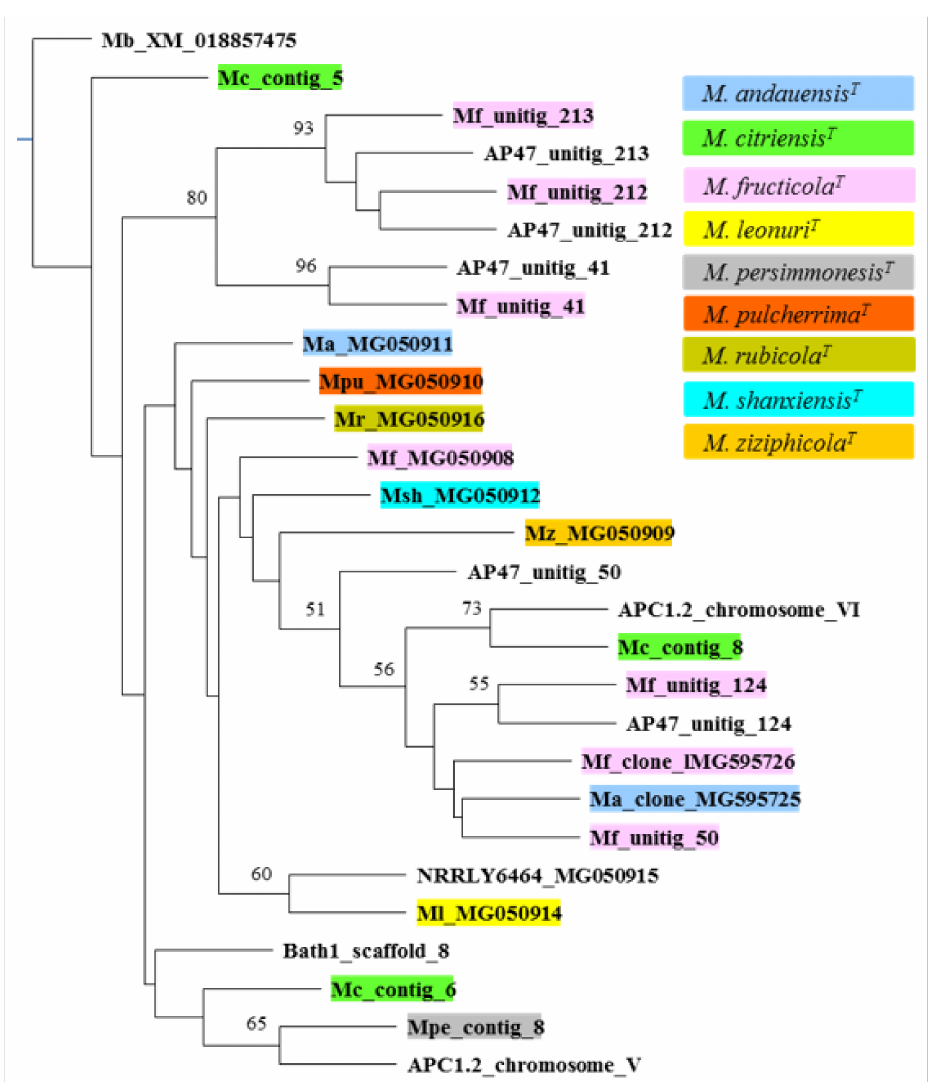
Figure 6. The neighbour joining tree of TEF1 barcode sequences. Sequences from type materials are marked with colours (see colour key at the top right). Boostrap values higher than 50 are shown at